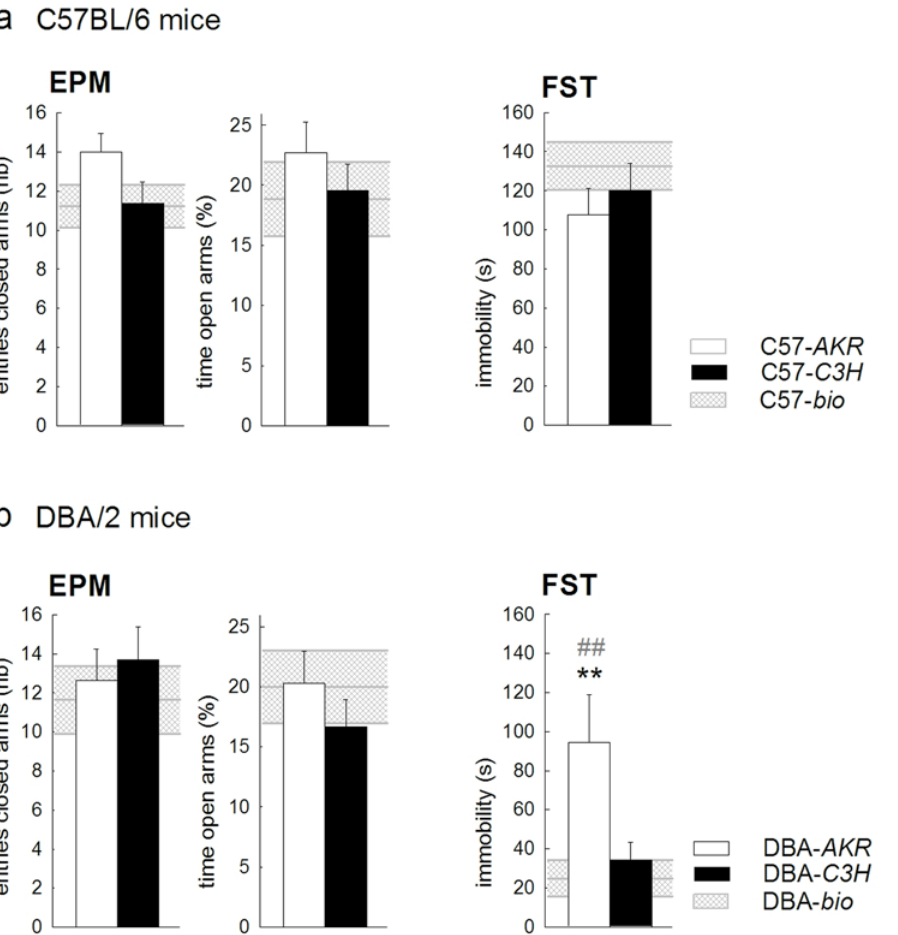
Figure 5. Impact of maternal environment on anxiety- and depression-related behaviors in (a) C57 and (b) DBA mice. EPM: Graphs show the total number of entries into the closed arms, an index of exploration (left panels) and the percentage of time spent on the open arms, a measure of anxiety (right panels). FST: Graphs show total immobility time in a 6 min test, a measure of depression-related behavior. Behavior of the reference groups (- bio ) is shown as horizontal hatched bands. Bars represent mean 6 SEM. C57- AKR (white bars) n =12, C57- C3H (black bars) n =14, C57- bio (hatched bands) n =14, DBA-AKR (white bars) n =8, DBA-C3H (black bars) n =10, DBA- bio (hatched bands) n =11. ** p , 0.01 compared to DBA- C3H . ## p , 0.01 compared to DBA- bio